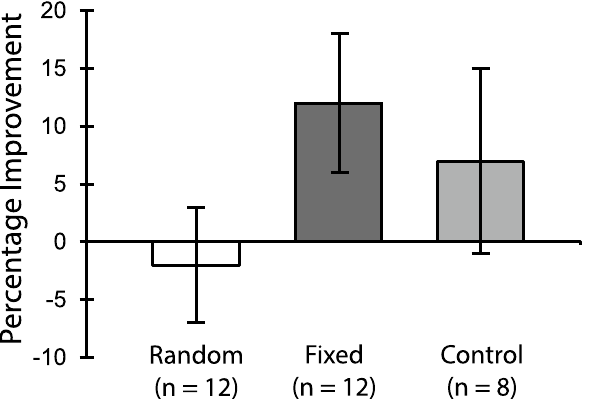
Figure 2. Percentage improvement on the trained temporal discrimination task. Percentage improvement is calculated from the change in difference limen between the first and last day of training (day 2–day 6), divided by an individual’s performance on the first day of training (day 2): %Improvement = (day 2 − day 6)/day 2 × 100. This calculation measures the amount of improvement from baseline relative to an individual’s initial performance on the task. Error bars indicate between-subjects ±